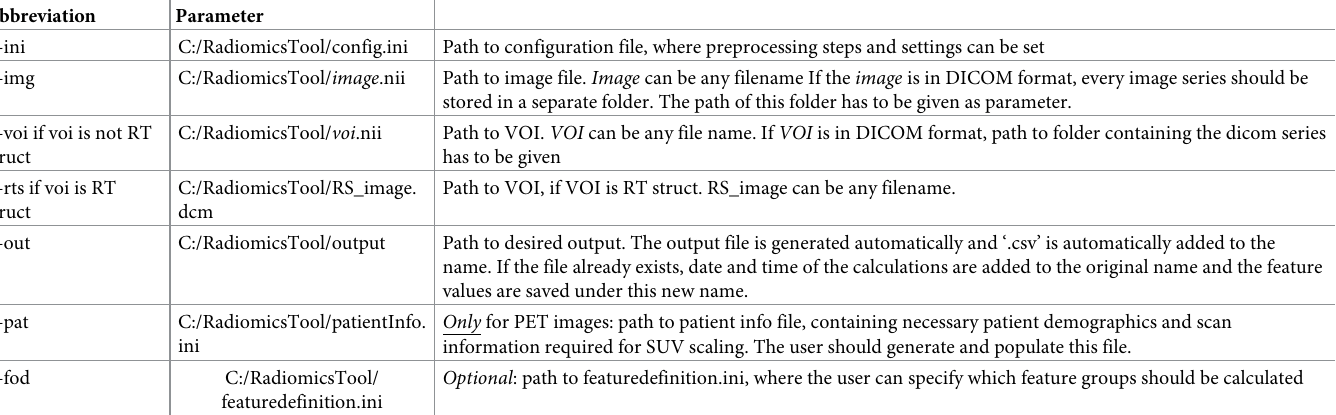
Table 1. Files required by RaCaT including their abbreviations that have to be given to the executable.